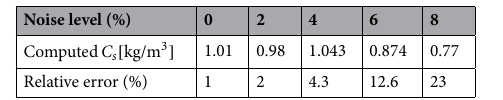
Table 4. Recovered injected concentration for different noise’s level.